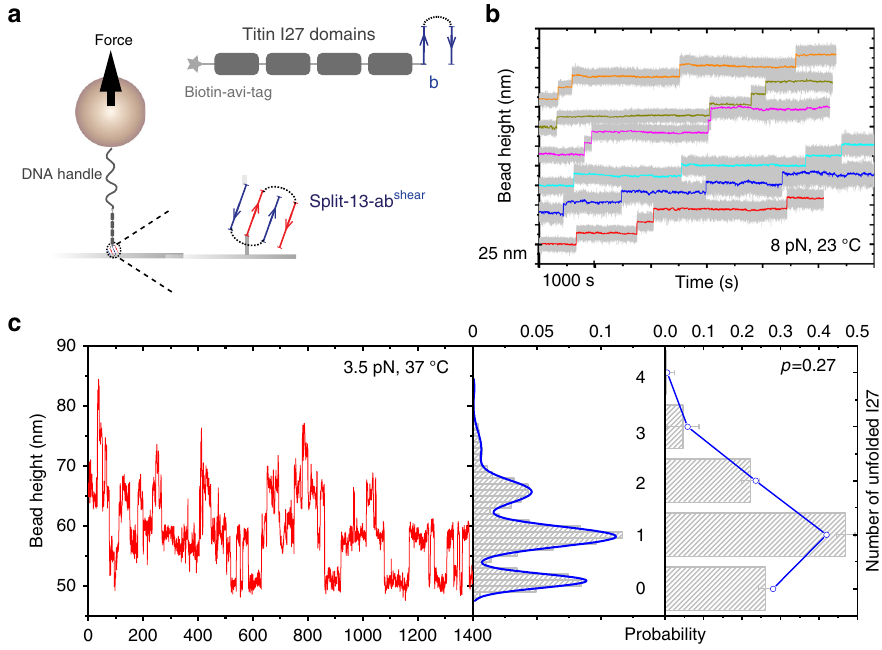
Fig. 5 Temperature-dependent titin I27 unfolding/refolding dynamics. a Experimental design of utilizing the split-13-ab shear helix-heterotetramer to anchor a protein construct (bio-4I27-b) that contains four repeats of titin I27 domains to coverslip surface. The I27 domains are spanned between an avi- biotin tag at N-terminus and the #13-b helix-hairpin at the C-terminus. The bio-4I27-b construct is speci fi cally tethered to the #13-a helix-hairpin coated bottom surface via formation of split-13-ab shear complex, and the N-terminus is tethered to the DNA-coated magnetic bead through biotin – streptavidin interaction (details are provided in Supplementary Note 2). b Six representative time traces of the bead height obtained from six independent tethers under a constant force of ~ 8 pN at 23 °C. The four stepwise extension increase events with a step size of ~15 nm indicate I27 unfolding. Colored lines are 200- points FFT smooth of the raw data (gray). c Left panel: a representative time trace of the bead height (20-points FFT smoothed) under a constant force of ~4 pN at 37 °C. The stepwise extension increase/decrease with step sizes of ~10 nm indicates unfolding/refolding of the I27 domains. Middle panel: the corresponding probability distributions of the bead height. Blue line is the multiple peak Gaussian fi tting of the bead height probability distributions. Right panel: The bar graph shows the probability of having n unfolded I27 domains in the four I27 domains obtained from the bead height distribution in the middle panel. The error bar indicates the standard error, which is obtained through multiple peak Gaussian fi tting of the bead height probability distributions. Blue curve indicates the fi tting of the bar graph to the binomial distribution, from which the probability of the unfolded state of a single I27 domain at this force is determined to be: p F ð Þ (cid:3) 0 : 27 at 37 °C. Source data are provided in Source Data fi le. Table 1 Thermal stability of the α -actinin 1 SR4 and titin I27 domains.